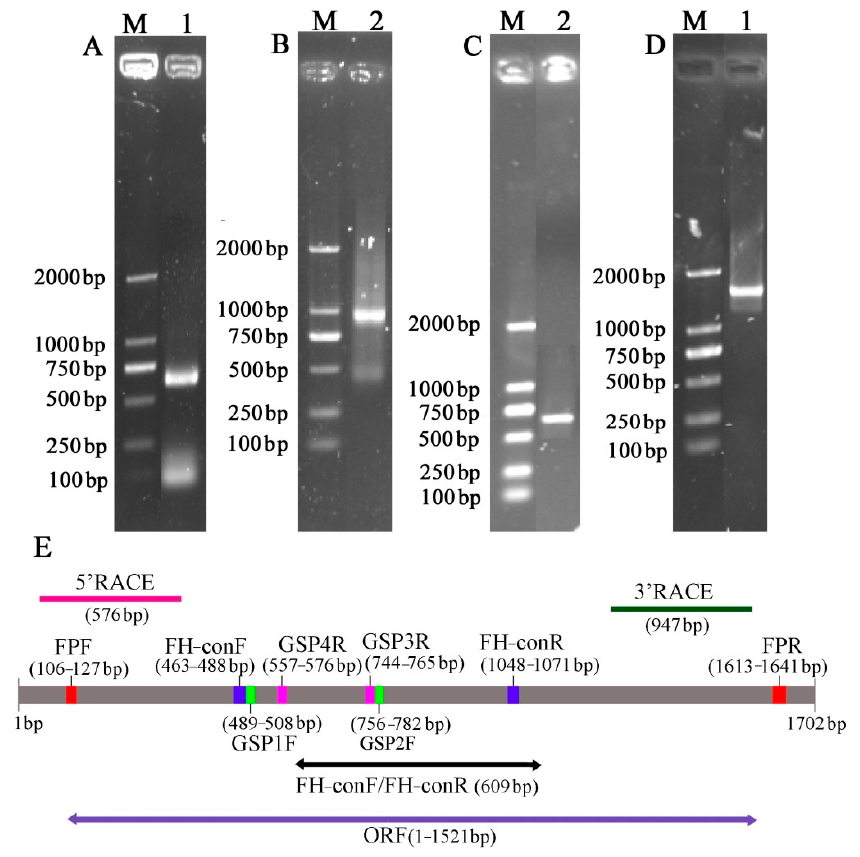
Figure 3. Isolation and identification of F3’5’H gene from B. acuminata flowers. ( A ) Conserved region sequence amplification electrophoresis. ( B ) 3 ‘end sequence amplification electrophoresis. ( C ) 5’ end sequence amplification electrophoresis. ( D ) Open reading frame. ( E ) The product lengths with different primers.